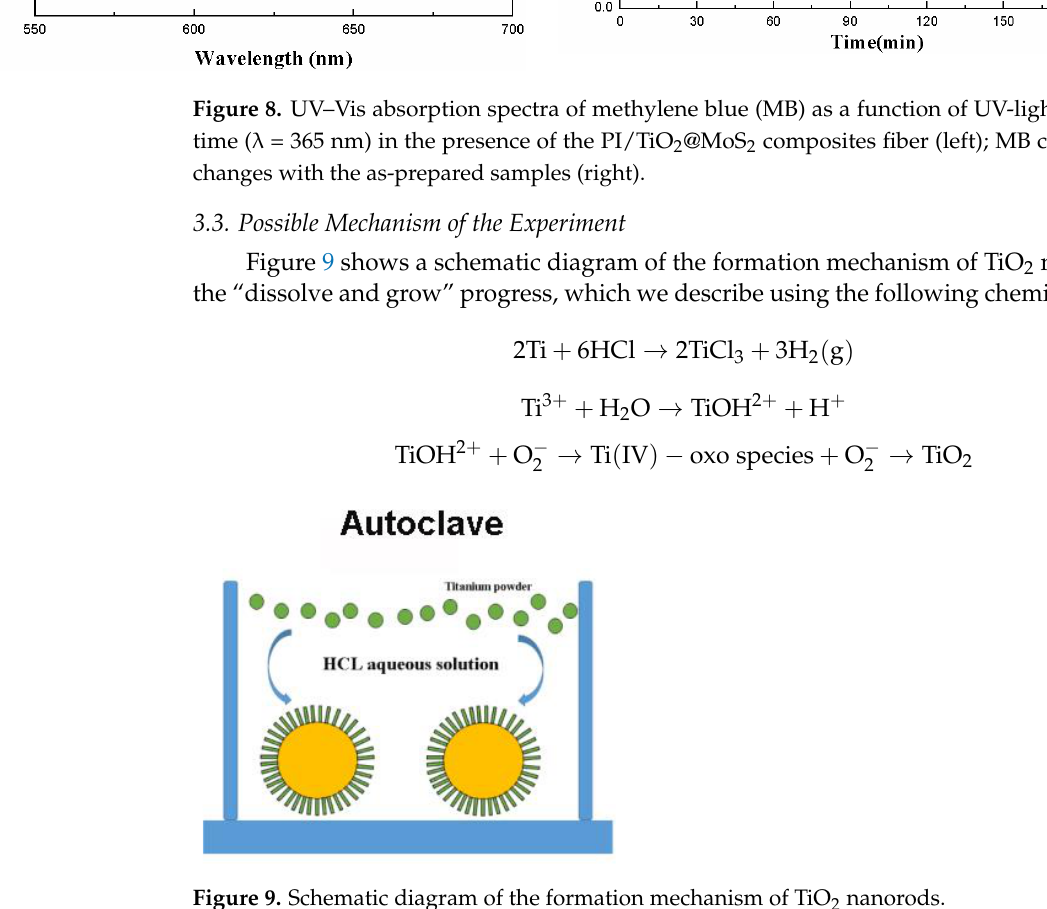
Figure 9. Schematic diagram of the formation mechanism of TiO 2 nanorods. According to the previous experimental results, a promotional mechanism is shown in Figure 10. Under UV-light irradiation, TiO 2 absorbs photons and creates electron – hole pairs. Because the conduction band (CB) of TiO 2 is higher than that of MoS 2 [41-43], the photoelectrons generated by CB of TiO 2 are easily transferred to MoS 2 , which improves the separation of photogenerated electron – hole pairs and enhances the photocatalytic